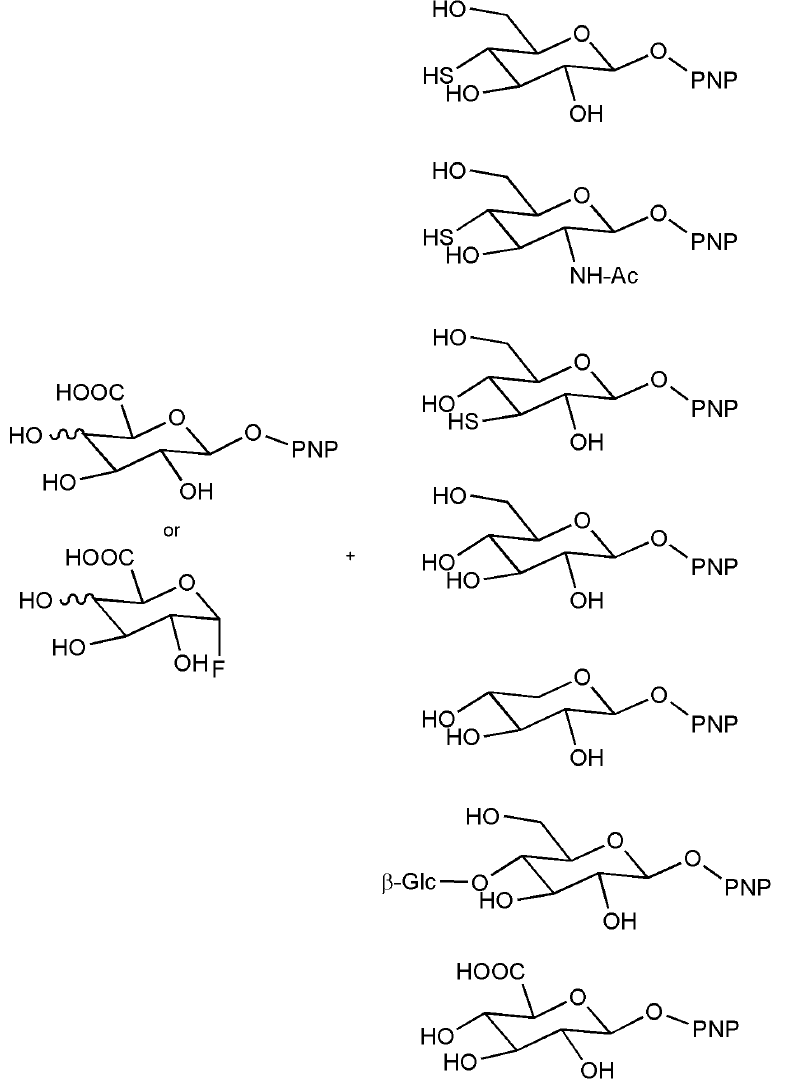
Figure 8. Donors and acceptors in thioglycoligase- and glycosynthase-based reactions